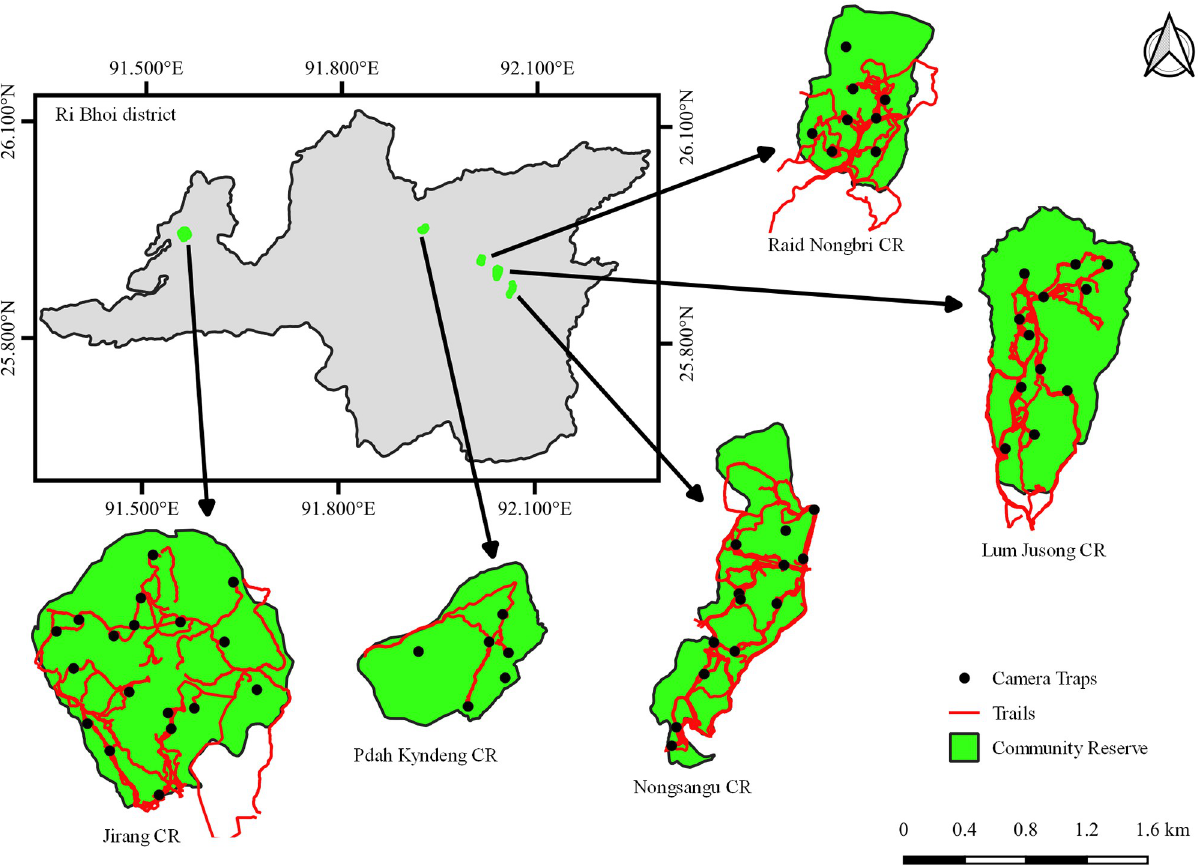
Fig 2. Map showing the camera trap locations and survey trails (both diurnal and nocturnal) for detection of mammals in each CRs of Ri Bhoi district. Republished from GADM database (https://gadm.org/) under a CC BY license, with permission from Global Administrative Areas (GADM), original copyright